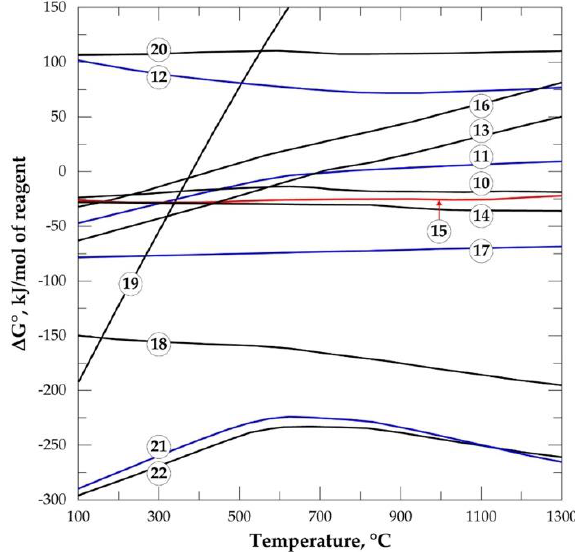
Figure 2. The standard Gibbs energies for roasting of spodumene for processes encountered in the literature (reactions (10)–(22)) versus temperature (data from the HSC Chemistry 5.1 software).